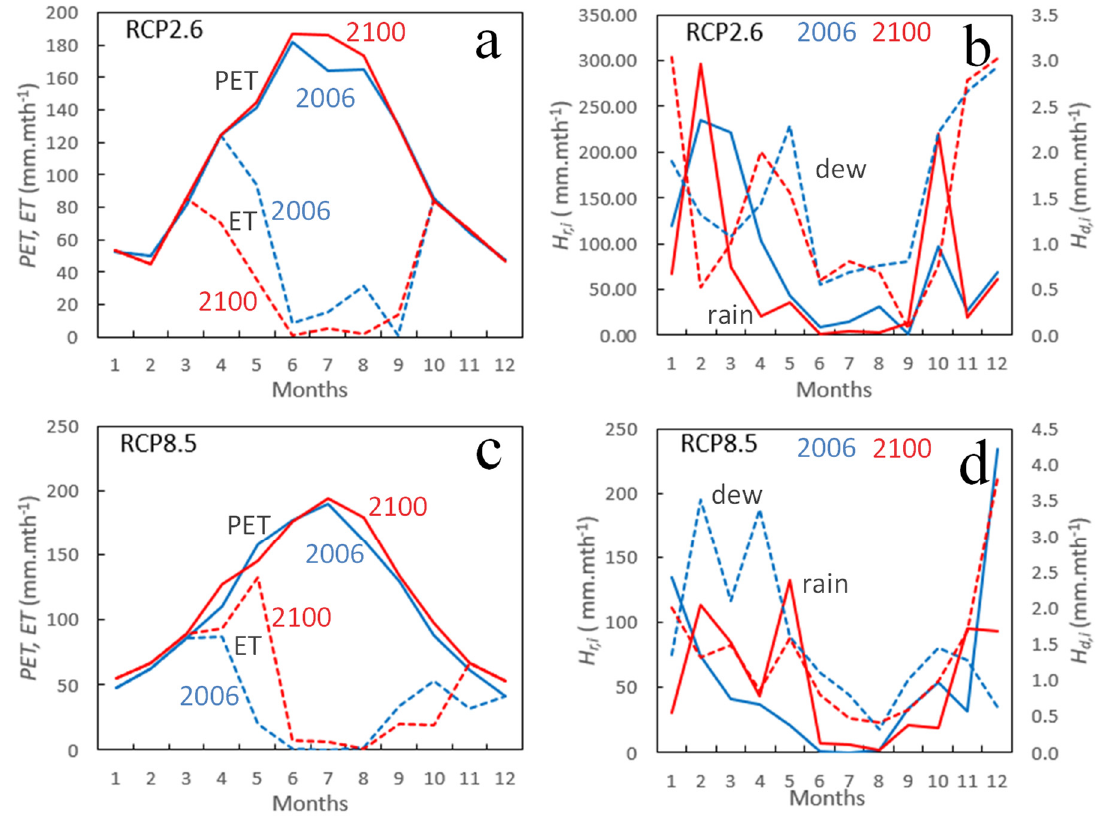
Figure 6. Variation between 2006 (blue curves) and 2100 (red curves) of the monthly mean of potential evapotranspiration PET (( a , c ), full lines), actual evapotranspiration ET (( a , c ), interrupted lines), rain monthly means H r,i (( b , d ), full lines) and dew monthly means H d,i (interrupted lines). The scenario RCP 2.6 is in ( a , b ) and RCP 8.5 in ( c , d ).